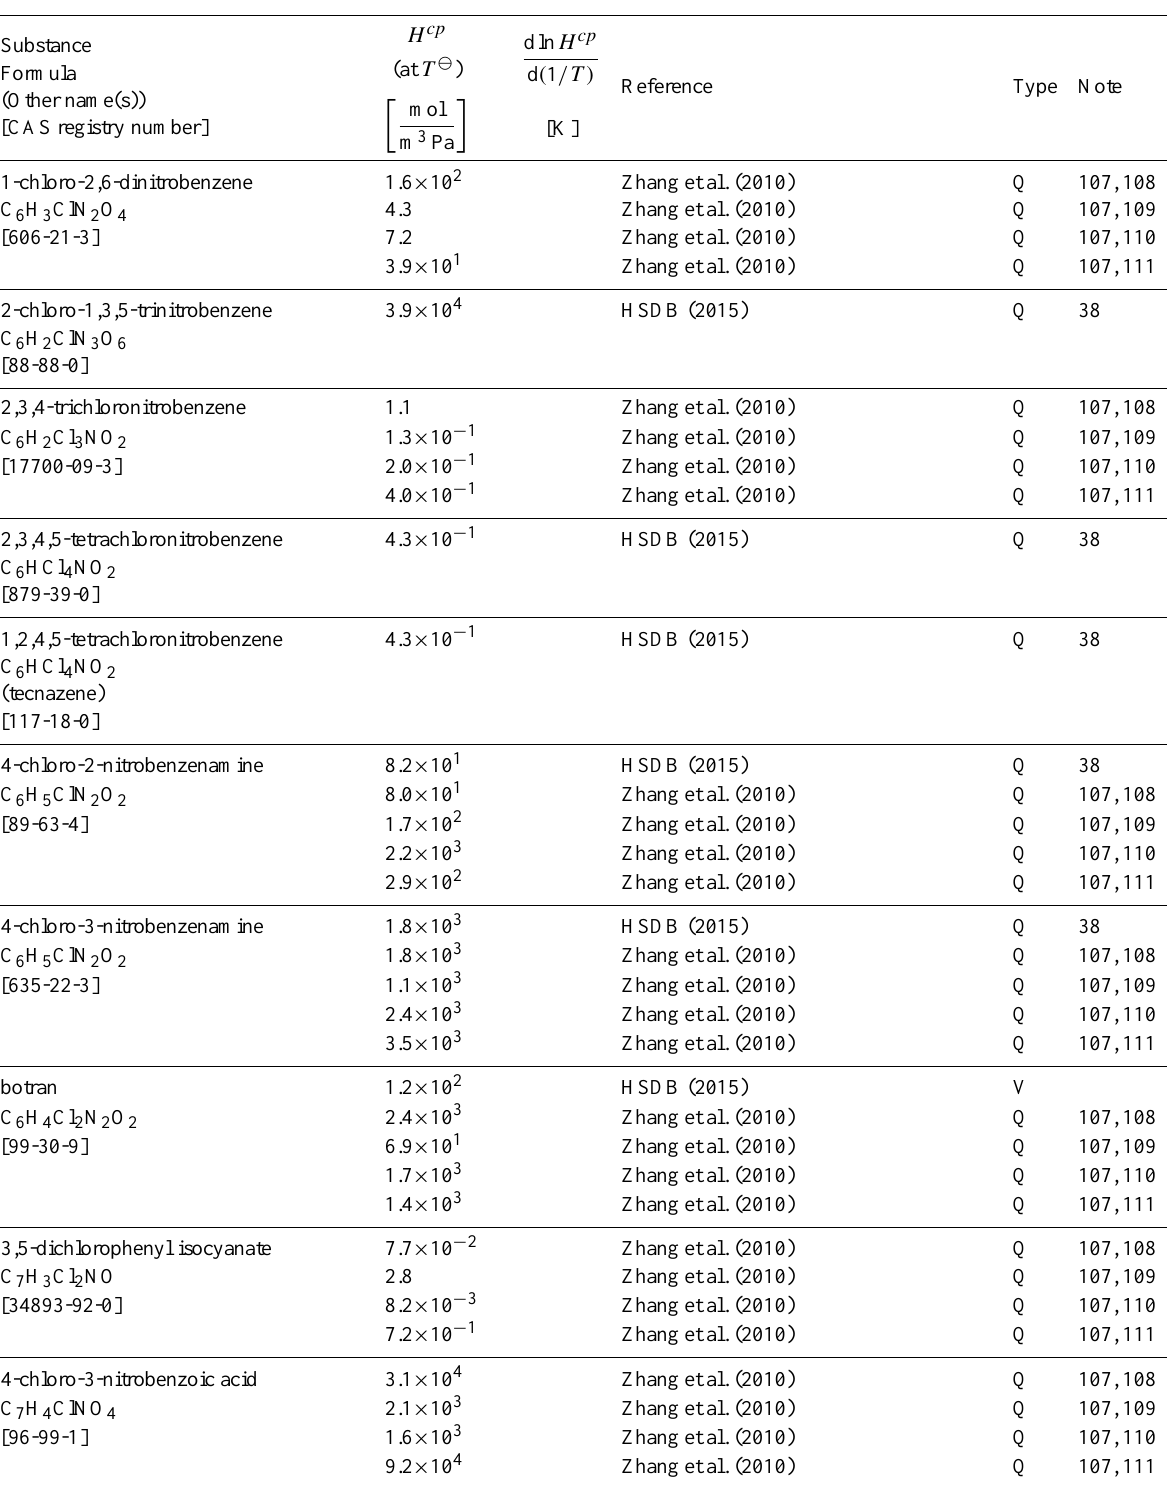
Table 6: Henry’s law constants for water as solvent